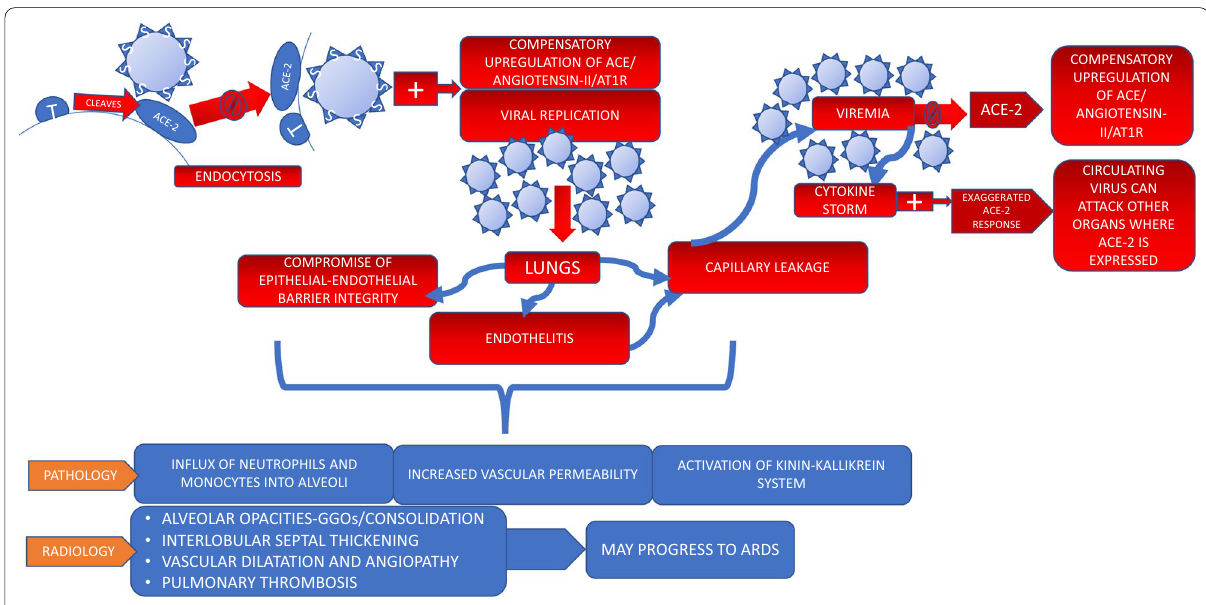
Fig. 3 Pathogenesis of COVID-19. T: TMPRSS2 (transmembrane serine protease